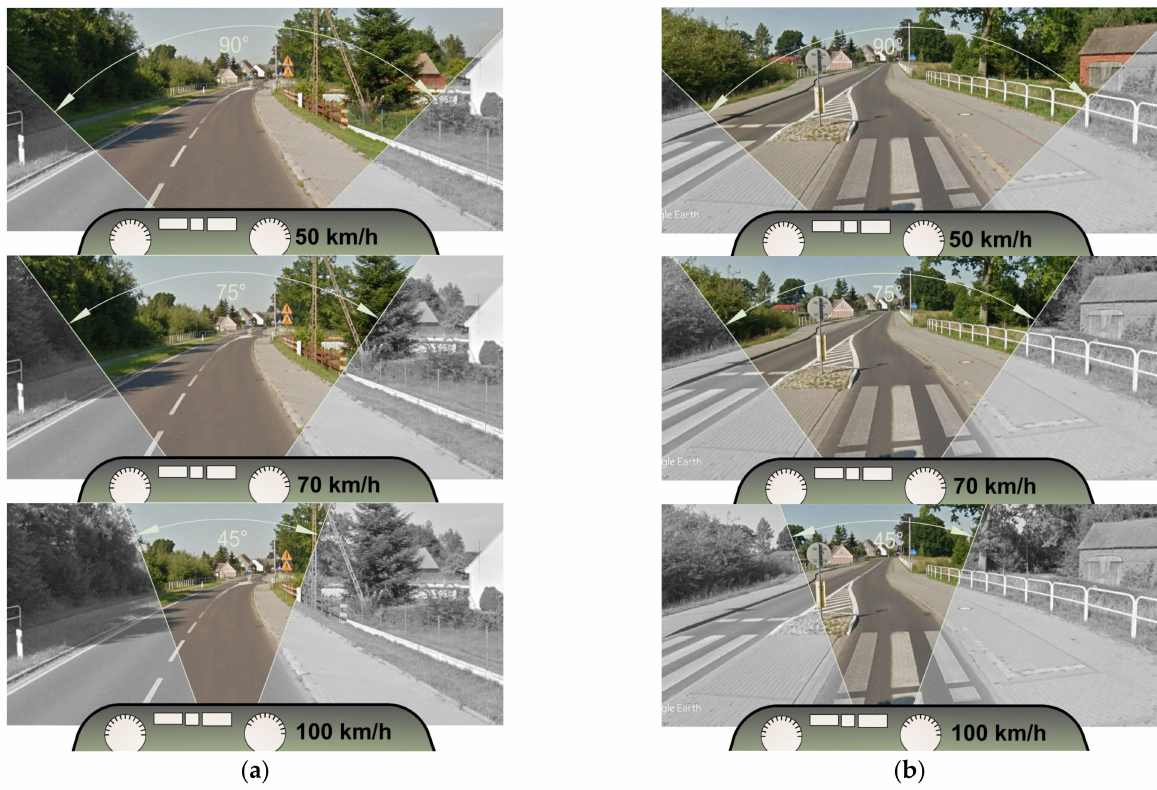
Figure 6. A visualisation of the drivers’ central and peripheral vision areas on section No. 1 with the greatest speed reduction ∆ v 85 = 22.5 km/h. ( a ) 100 m before chicane at v : 50, 70 and 100 km/h; ( b ) in the axis of the chicane at v : 50, 70 and 100 km/h. (Background photographs source: Google Earth